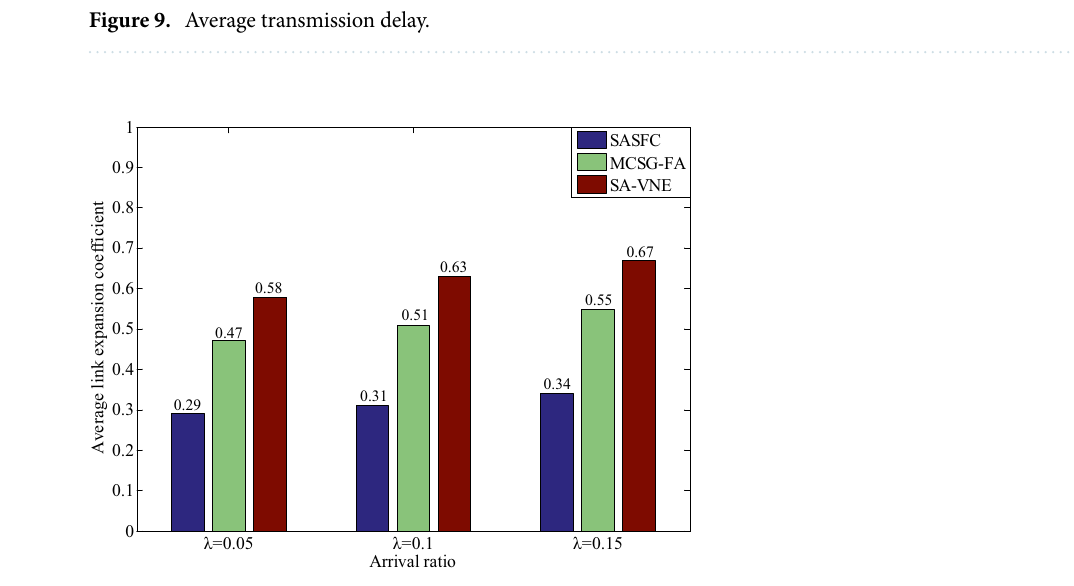
Figure 10. Average link expansion